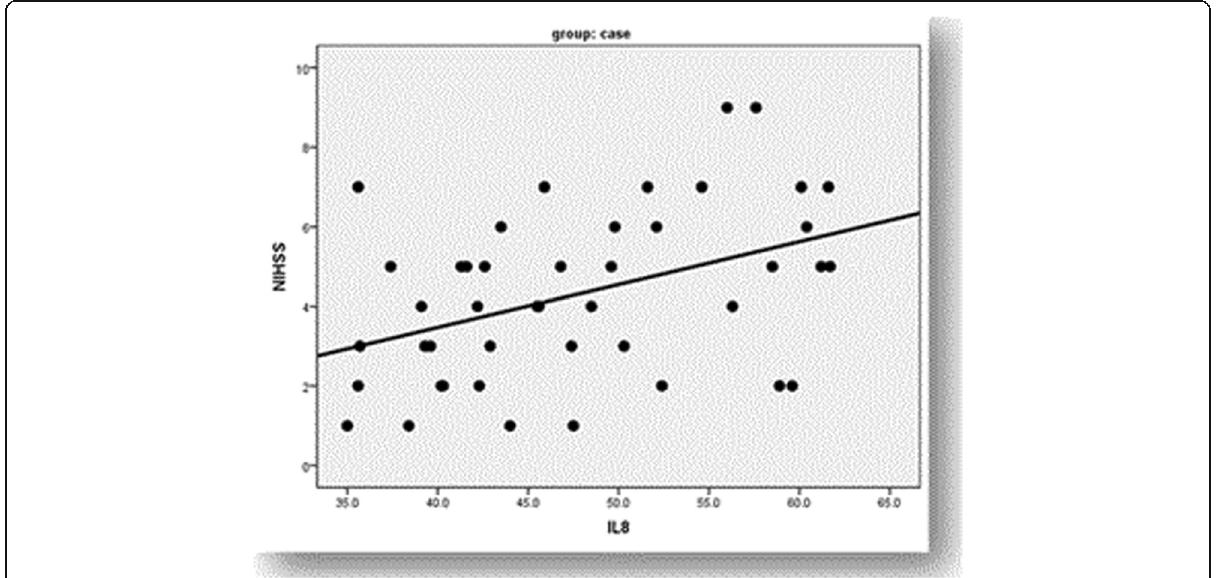
Fig. 2 Correlation between IL-8 serum level and disability of stroke